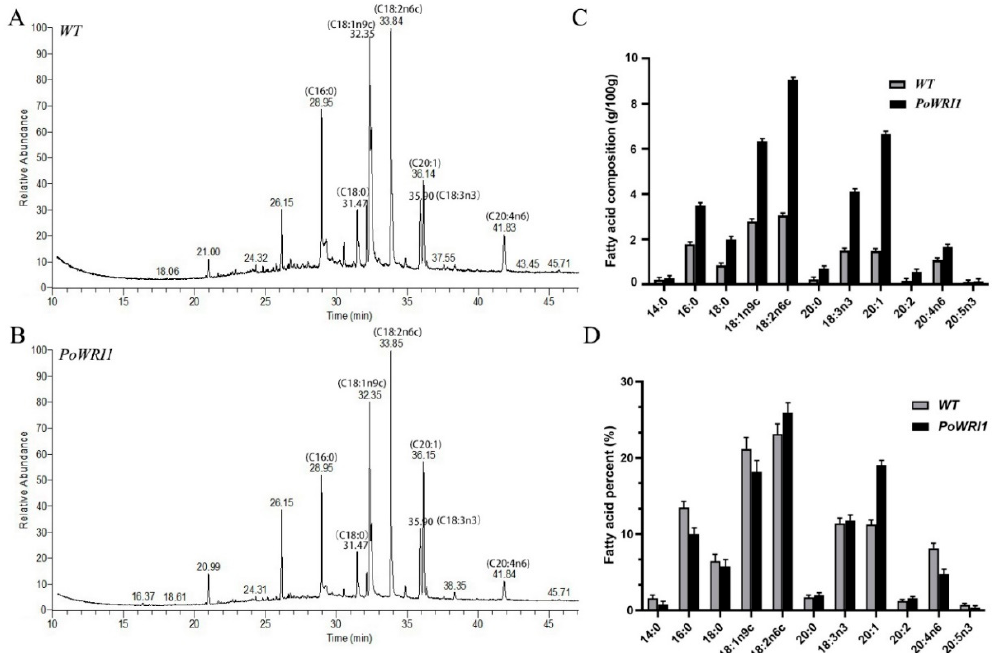
Figure 7. Analysis of fatty acid content in Arabidopsis seeds. ( A , B ) GC-MS analysis of fatty acids isolated from the Arabidopsis seeds. ( C , D ) Fatty acid content and percentages of each component isolated from the Arabidopsis seeds. Error bars are s.e. ( n = 3).